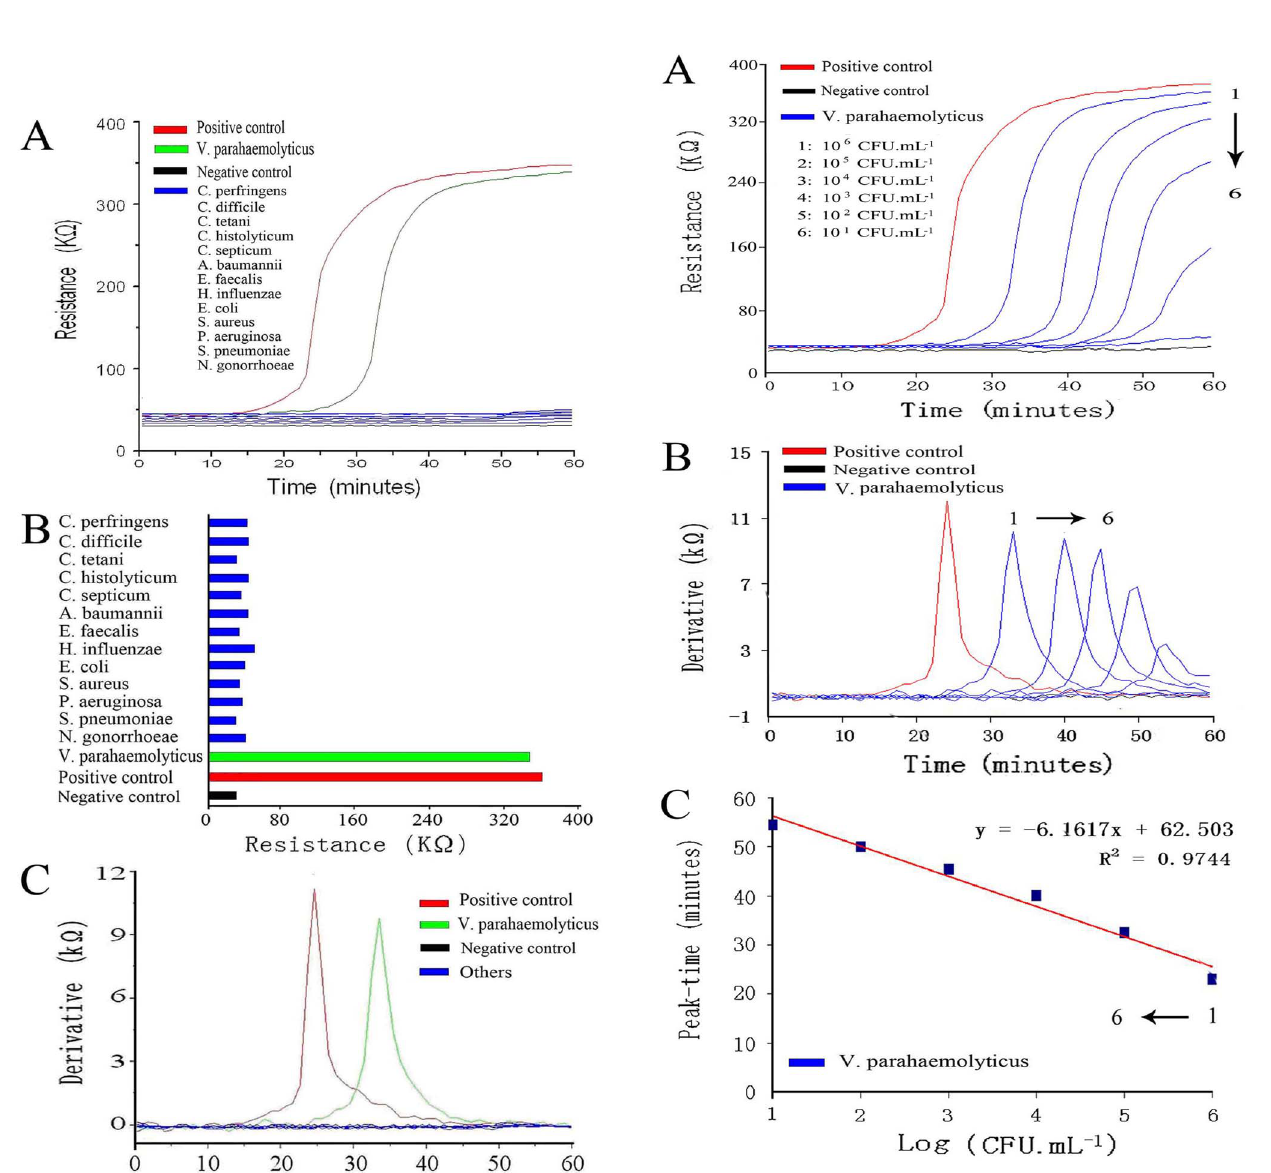
Figure 3. Sensitivity and regression analyses of the real-time resistance measurement. A. The real-time resistance curve of V. parahaemolyticus in a concentration gradient. B. The derivative analysis of the real-time resistance measurement of V. parahaemolyticus . C. The regression analysis of the real-time resistance measurement of V. parahaemolyticus. Three samples of the same bacterial concentration were measured twice and all values were recorded as mean(n=6).